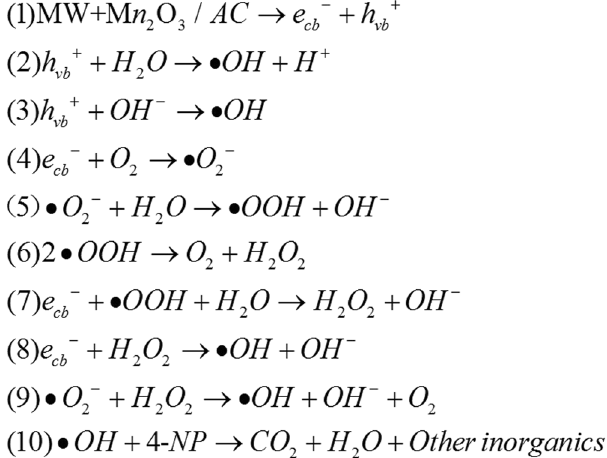
Figure 4. Illustration of generation of ∙OH in the process of